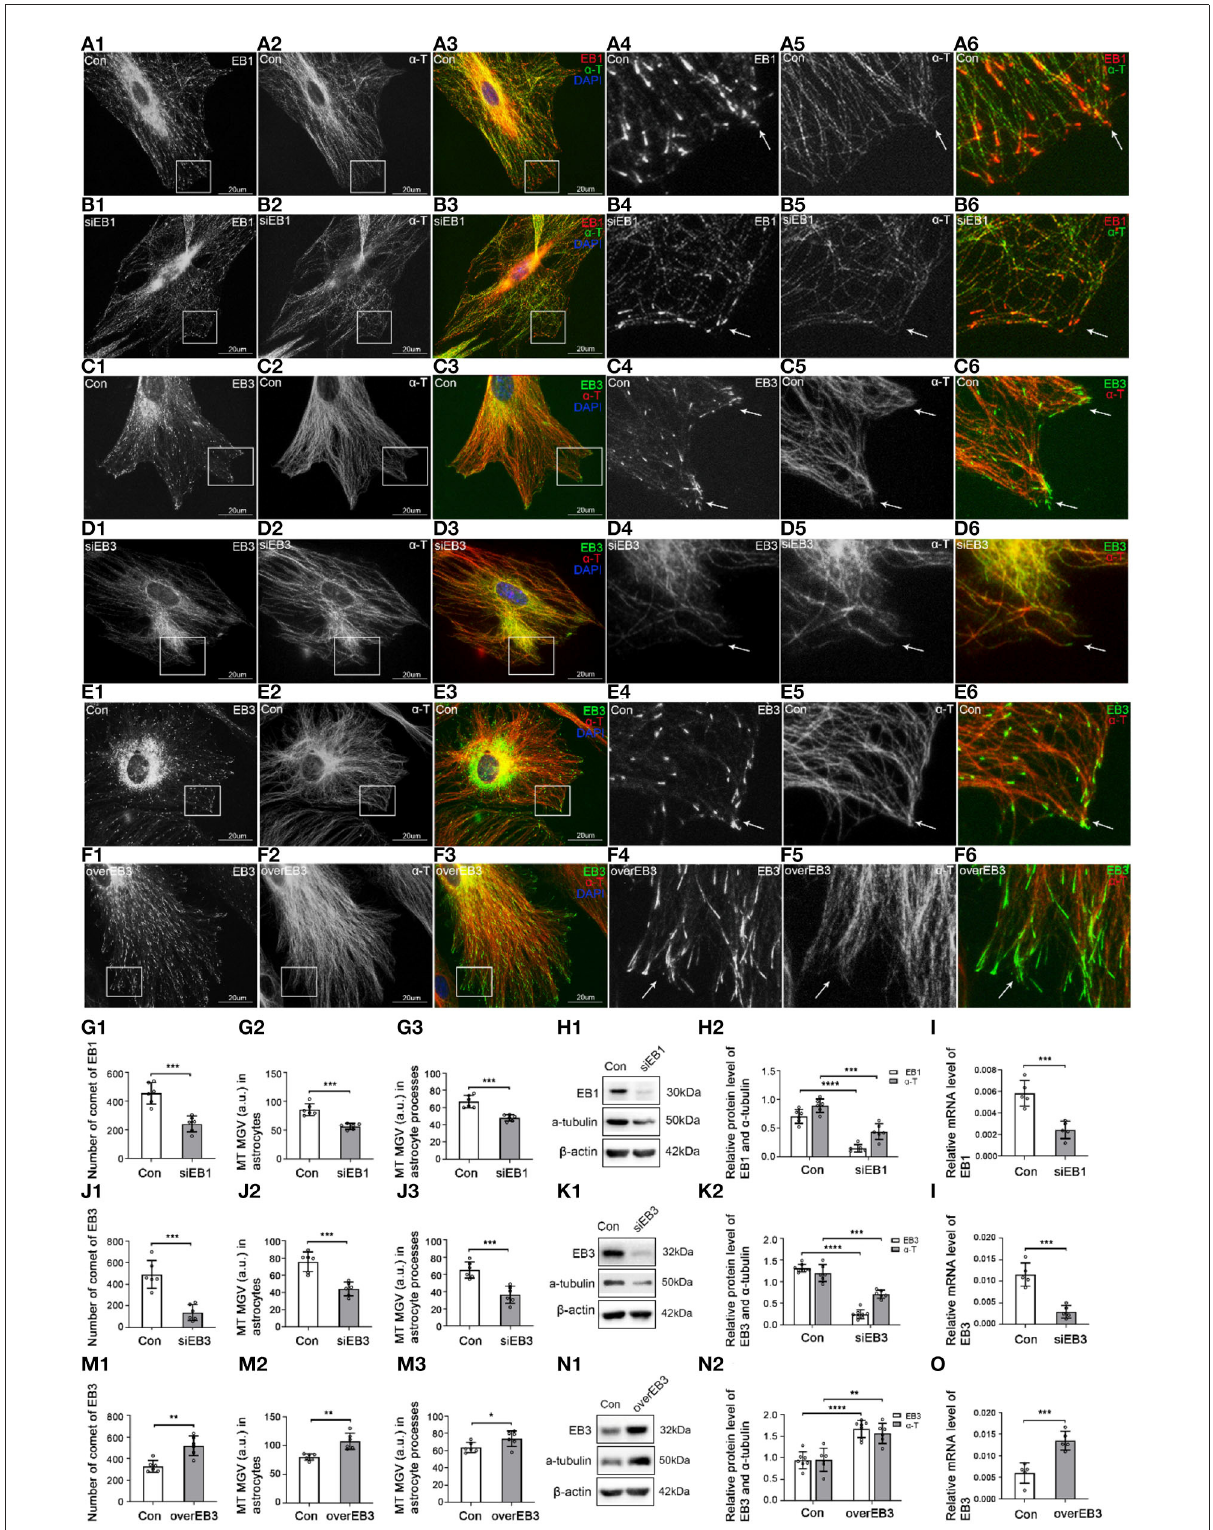
FIGURE3 The expression of EB1/EB3 and α -tubulin after EB1/EB3 was silenced or EB3 was overexpressed in astrocytes. (A–F) Immunofluorescence showed that α -tubulin [ (A,B) green signal; (C–F) red signal] was co-expressed with EB1 [ (A,B) red signal] or EB3 [ (C–F) green signal] in astrocytes both in the control group [Con (A,C,E) ] and EB1/EB3 silence group (B,D) or EB3 overexpression group (F) . (G,J,M) The number of EB1/EB3